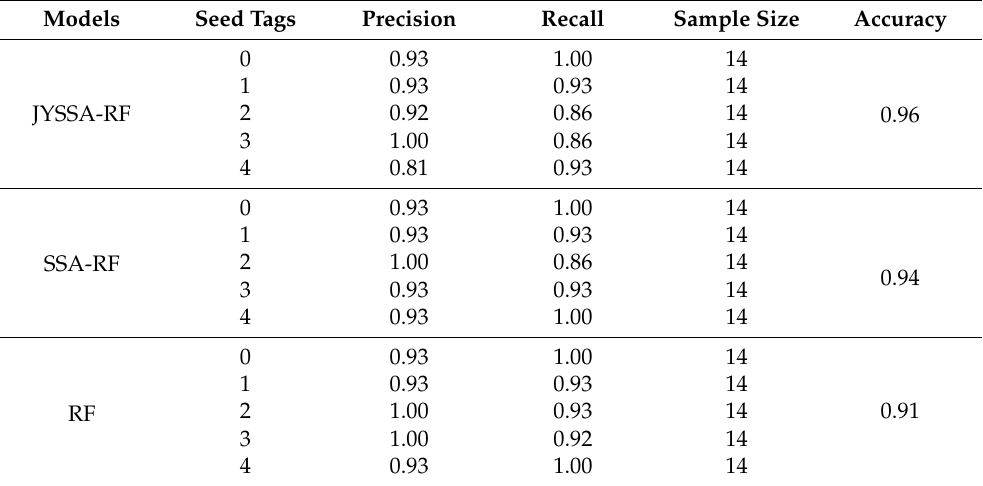
Table 7. Validation set results of the three varieties of models with 186